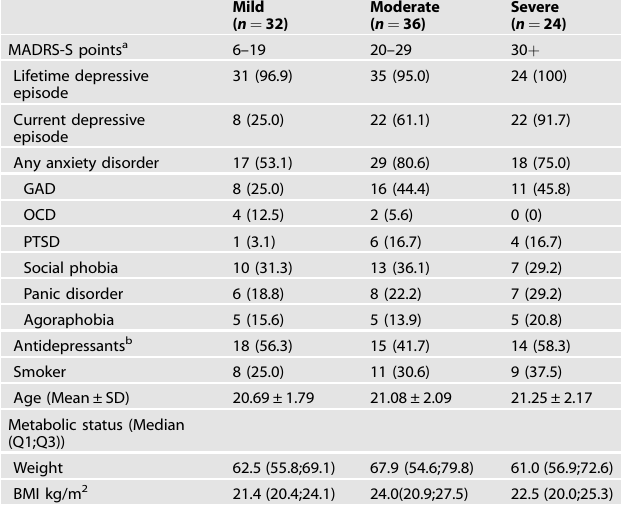
Table 1. Characteristics of the 92 female general psychiatric patients from UPP (discovery cohort) aged 18 – 25, grouped according to MADRS-S